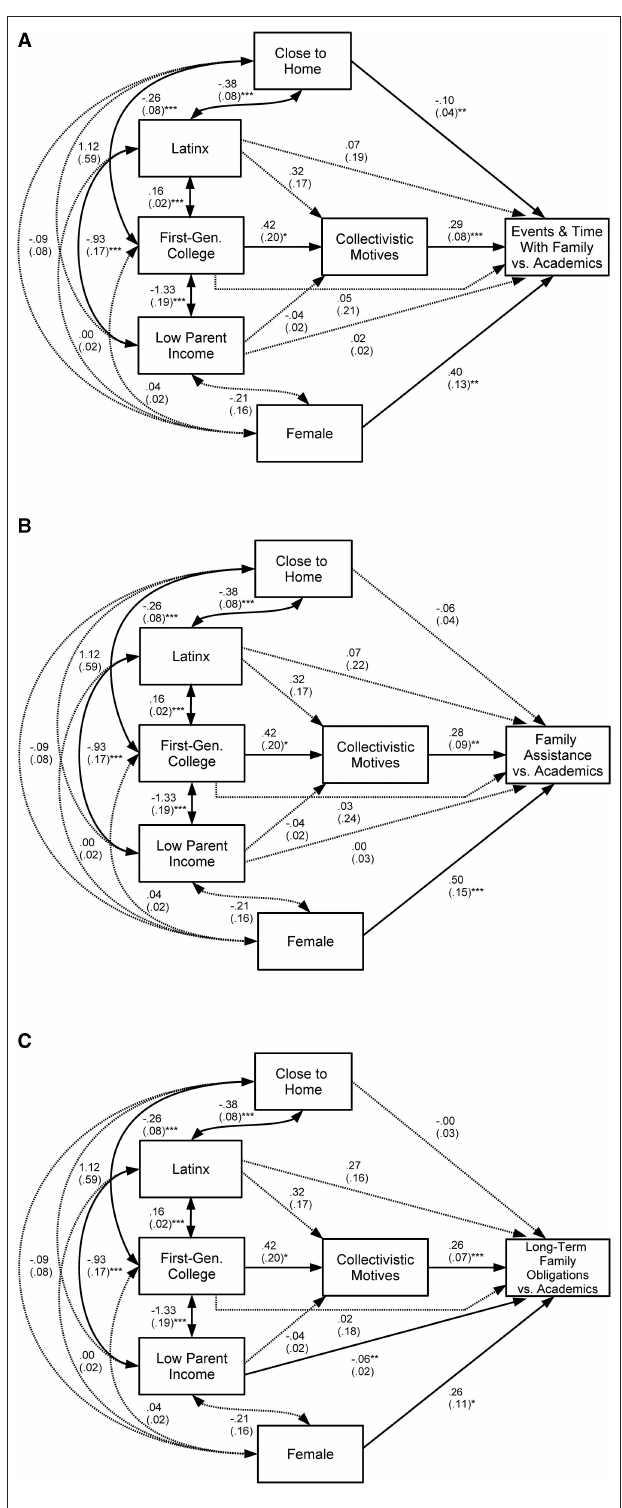
FIGURE 3 | Antecedents of the three forms of home-school cultural value mismatch: (A) events and time with family, (B) family assistance, and (C) long-term family obligations vs. academics. Included are unstandardized estimates (with standard errors); a solid line indicates significance and a dashed line indicates non-significance; *** p < 0.001, ** p < 0.01, * p <